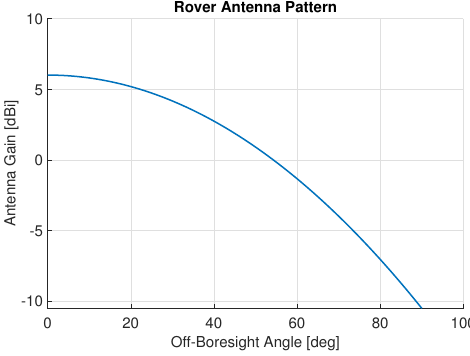
Figure 5. Antenna pattern of the receiver. Table 3. Characteristics of the rover LCNS S-band